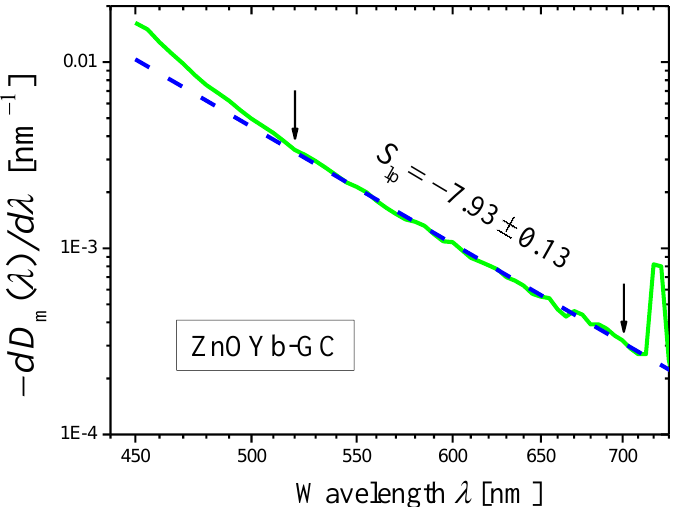
Figure 12. A log–log plot of the dependence of ( − dD i m ( λ ) / d λ ) on λ (green curve) constructed for the measured optical density D m ( λ ) of sample of the glass-ceramic ZnOYb-GC with the thickness h = 3.02 mm. The portion of the curve limited by arrows is approximated by blue dashed straight line using the least squares method, and the slope S lp of the straight line is indicated in the figure. The wavelength step Δ𝜆 = 5 nm was used.